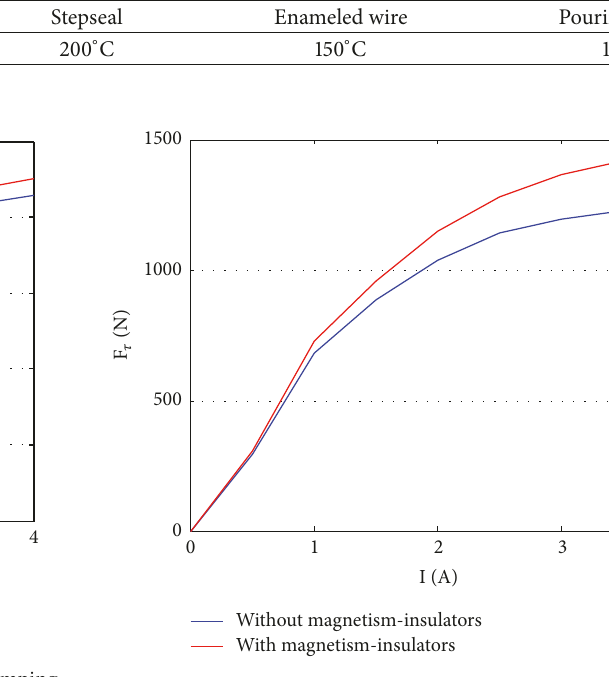
Figure 14: Shear stress at different